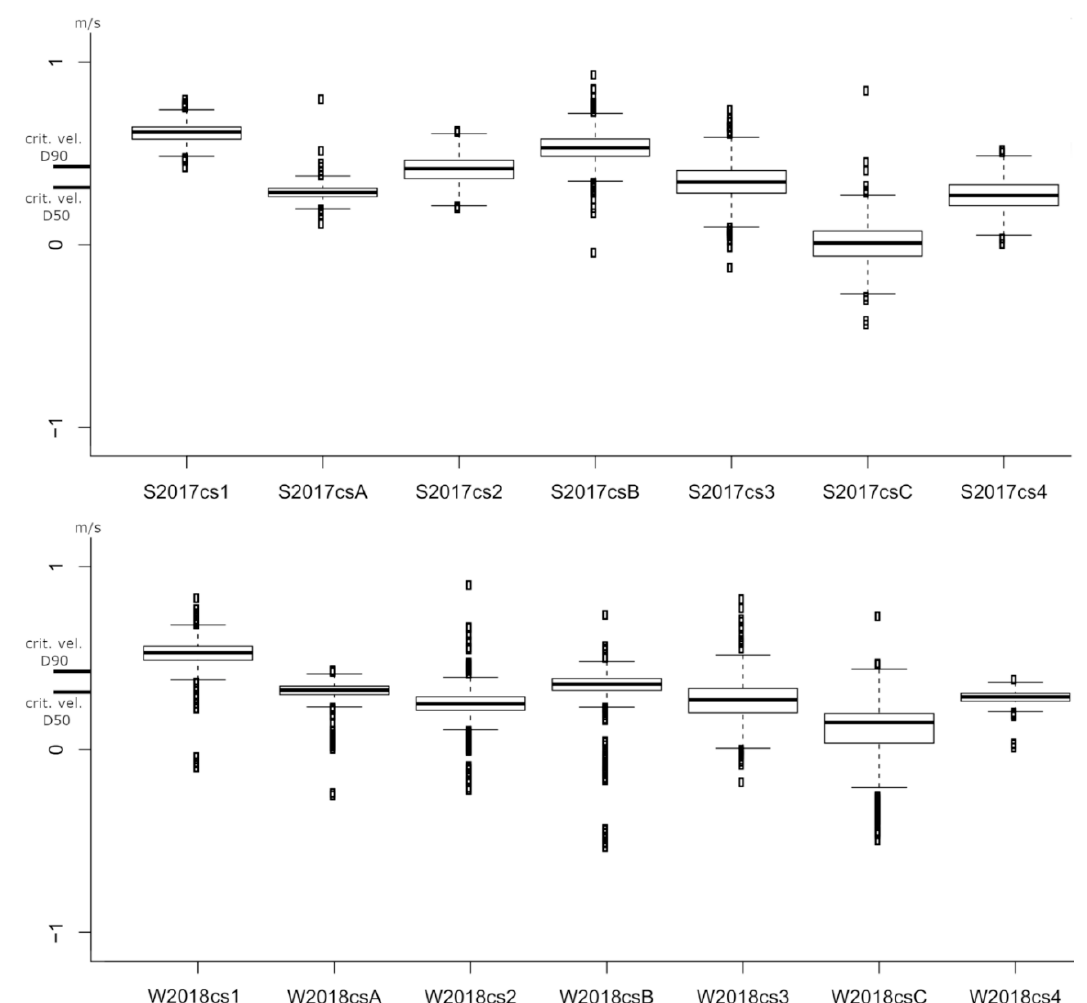
Figure 10. The boxplots of the streamwise velocity (m/s) of the deepest cells at all measurement locations on W2018 (mid-winter ice-covered flow conditions) and S2017 (spring snow-melt flow conditions). The critical velocity thresholds for the movement of the largest measured D50 and D90 grain sizes are shown. Note that the deepest cells are at different depths depending on the measurement times. The boxplots show the median line, 1st and 3rd quartiles (25 and 75 percentile ranges) within the boxes, maximum observations below upper and lower fences (i.e., the fence is 1.5 times the difference between the 3rd and 1st quartiles), and outliers (dots).